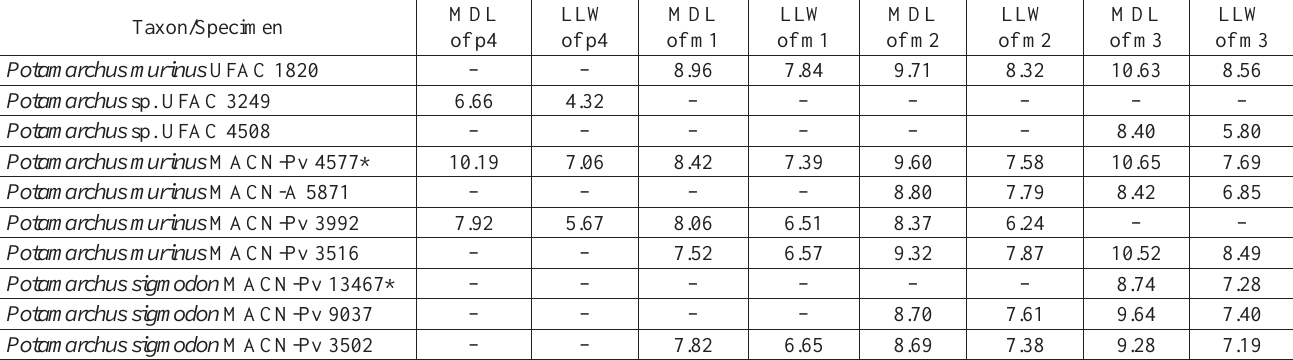
Table 3. Measurements (in mm) of the lower cheek teeth of potamarchines from the Solimões Formation and comparative specimens. Abbrevia- tions: LLW, linguolabial width; MDL, mesiodistal length. Taxon/Specimen